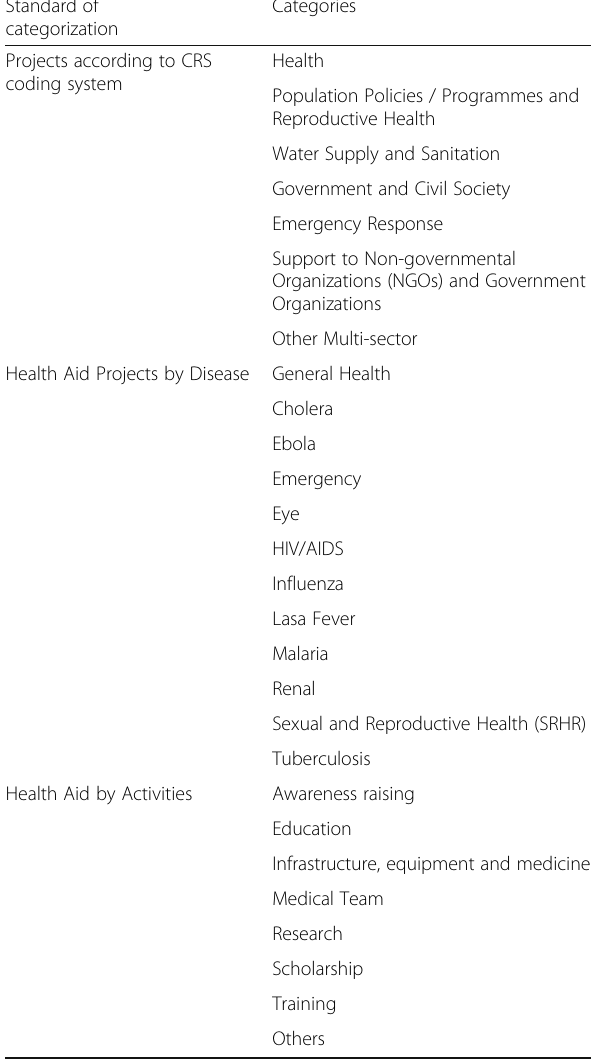
Table 1 The standard of categories of projects Standard of